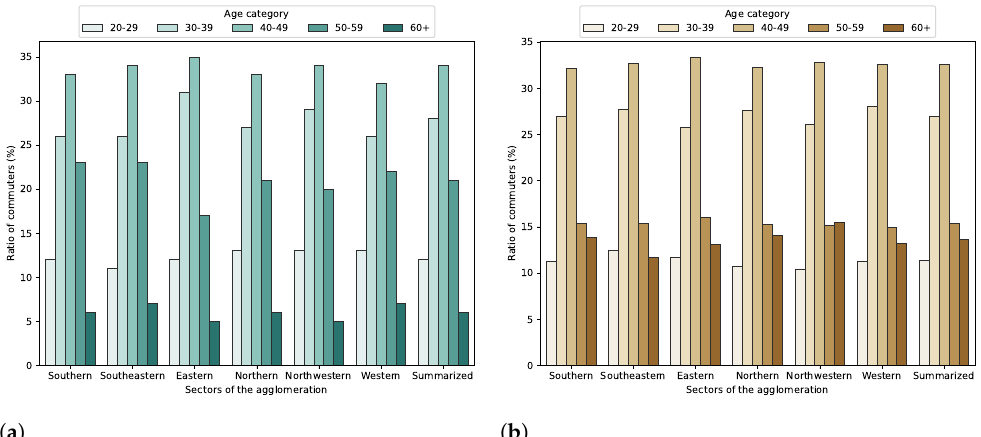
Figure 15. Distribution of the commuters by age categories and the sectors of the agglomeration (%). Comparison between microcensus data (Table 1 in [9]) ( a ) and mobile network data ( b